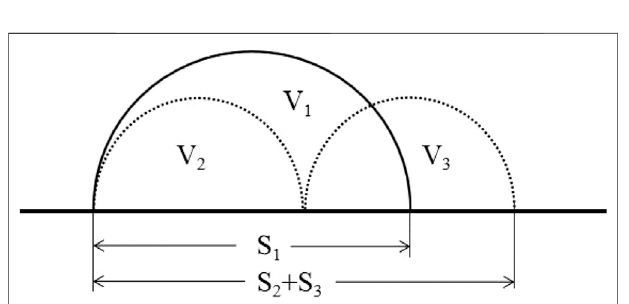
FIGURE 3 | Schematic diagram of different oil contraction patterns in an EWD pixel; when an oil droplet splits into two droplets, the covered area between the oil and the hydrophobic insulator layer becomes larger, although the volume remains the same, that is, V 1 (cid:2) V 2 + V 3 , S 1 < S 2 + S 3 .